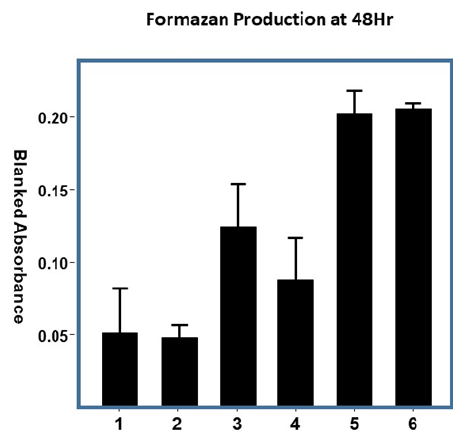
Figure 6. Cell Viability. Cell viability in response to the treatments was assessed after 48 h. exposure by measuring the reduction of a tetrazolium salt to formazan ( n = 4). Samples of 8 mm diameter cotton disks were treated with the designated solution of copper nanoparticles: Sample (1) Greige Cotton + 100 mM Asc. Acid (Add on per weight of cotton: 162 g/mg); (2) Greige Cotton + CuNP + AA (Add-on per weight of cotton 609 g/mg); (3) Greige Cotton + 2 mM CuCl 2 + 10 mM Asc (Add on per weight of cotton: 11 g/mg cotton). Acid; (4) Greige Cotton + 100 mM CuCl 2 + 1 M Asc. Acid (Add on per weight of cotton: 515 g/mg; (5) 100 percent greige cotton only; (6) medium only. Error bars represent ± 1 standard deviation.